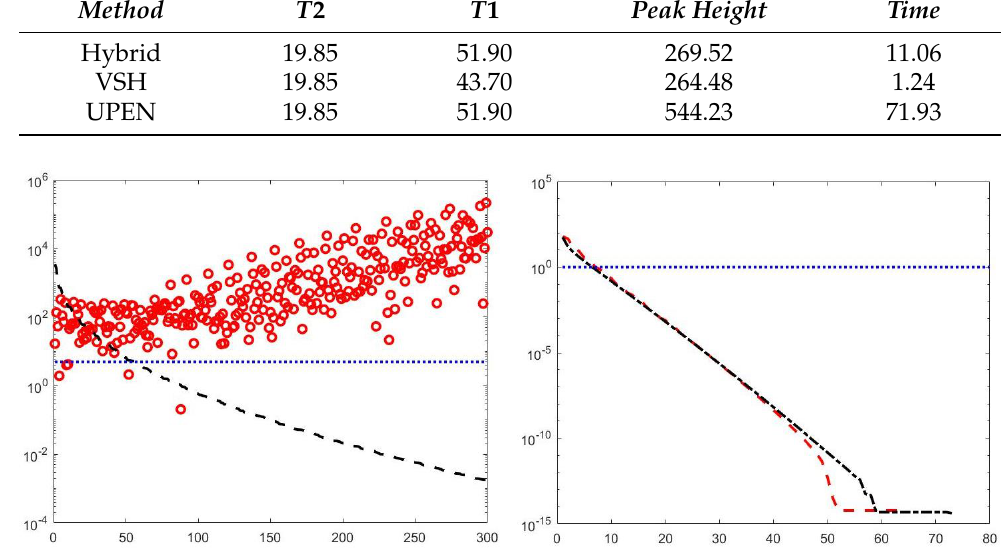
Figure 13. Left : singular values (black dashed line) of K and solution coefficients (red circles). Only the first 300 singular values are depicted. Right : Singular values of K 1 (red dashed line) and K 2 (black dashdotted line). The horizontal line corresponds to the value τ = 1.